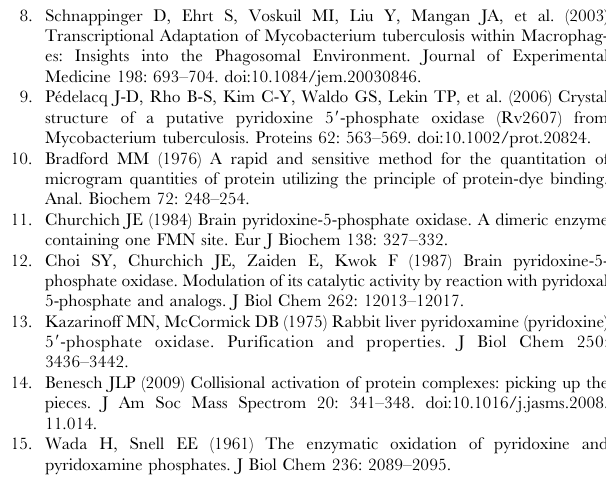
Figure S1 Identification of cofactor bound to Rv2607 by electrospray ionization mass spectrometry. Cofactor was extracted from Rv2607 by heat denaturation. FMN has a molecular weight of 456.2 Da.